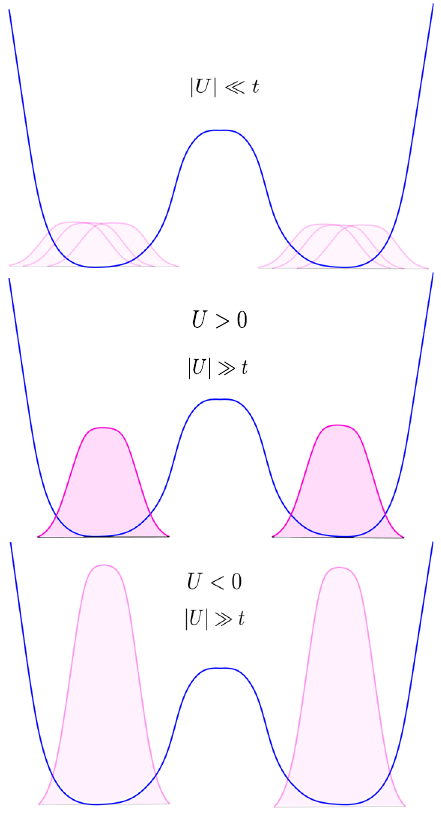
Fig. 1 We pictorially represent the ground states corresponding to the three regimes of interest. They are depicted in the order in which they appear in the text (from top to the bottom): the coherent state, the Fock state and the cat state. The opacity in the figures above represents how localizedthestateis.Thecoherentstateisacompletelydelocalizedstate with a non-vanishing projection onto all of the basis number states, the Fockstatecorrespondstotwolocalizedplacesatwhichthestateexhibits a peak and the catstate corresponds toa